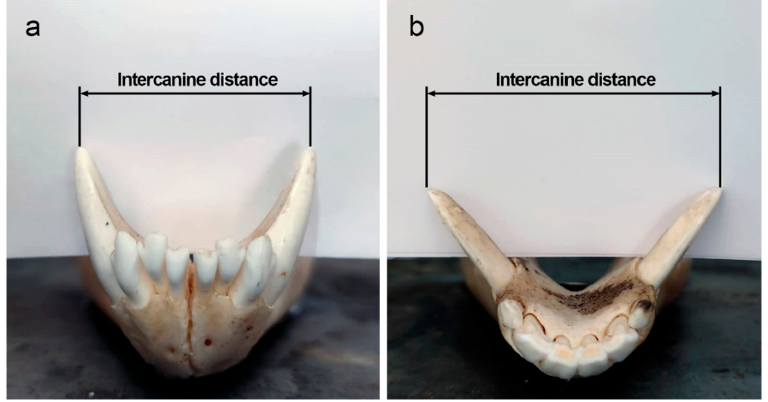
Figure 2. Intercanine distance as measured at the mandibular canine cusp tips in ( a ) Canis lupus and ( b ) Sus scrofa . Images courtesy of C. Tanga. ( b ) Sus scrofa . Images courtesy of C. Non-metric dental traits (e.g., presence and size of cusps, form of fissures on occlusal surfaces of premolars and molars, form of ridges, presence of pits) also play a significant